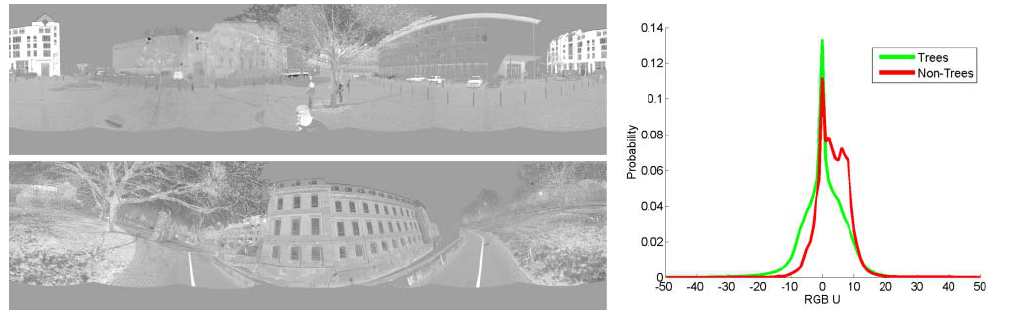
Figure 10. u values of the Luv representation of the color channel, and their tree/non-tree distribution.